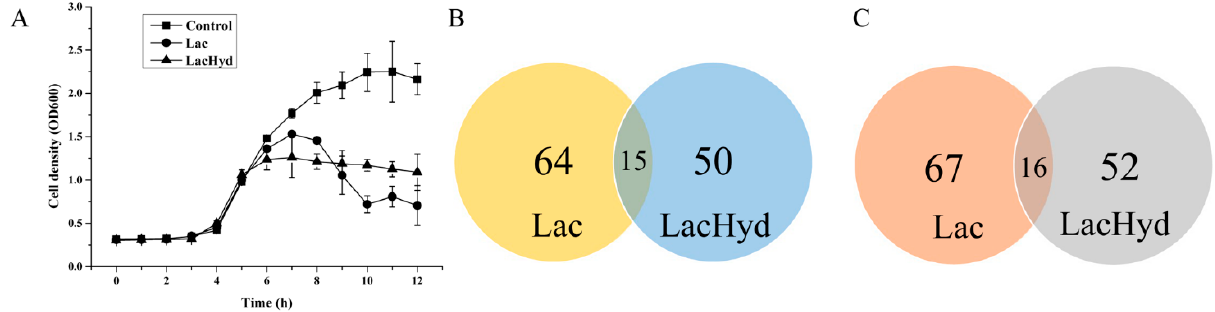
Figure 1. General comparison of the control, Lac group and LacHyd group. ( A ) Growth curves of the three groups. ( B ) Venn analysis of the shared genes that were upregulated compared to the control in the two groups. ( C ) Venn analysis of the shared genes that were downregulated compared to the control in the two groups. The pH values of the three groups were 7.0., 5.5 and 5.5, respectively; the H 2 O 2 concentration of the LacHyd group was 0.5 mM.